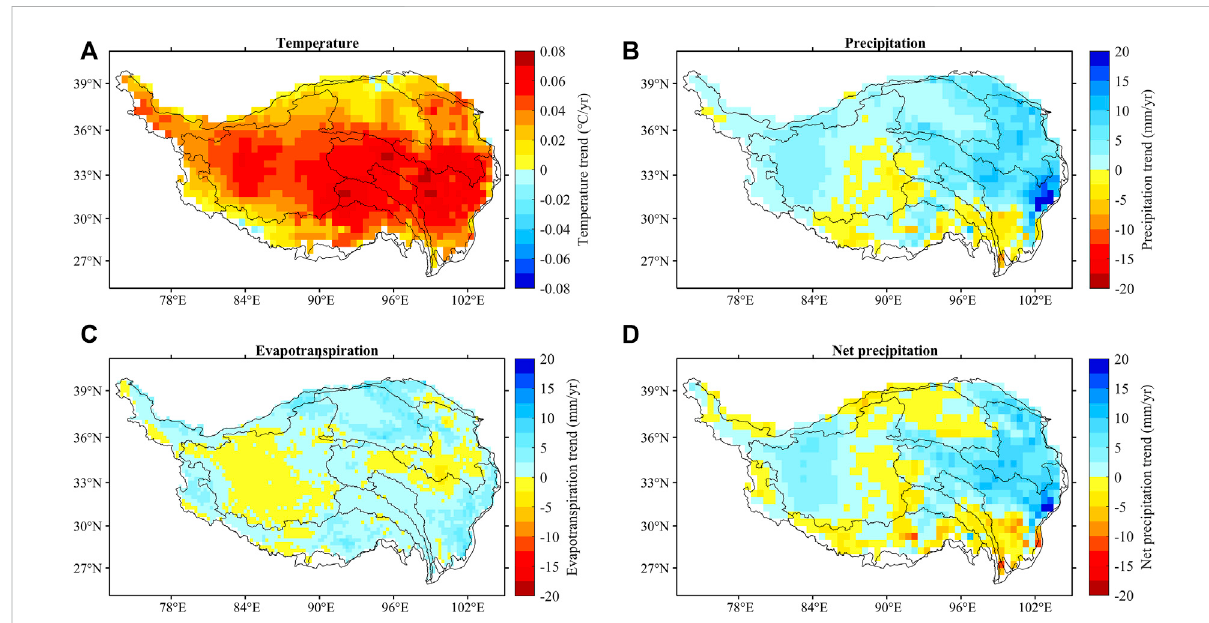
FIGURE 7 The spatial changes of temperature (A) , precipitation (B) , actual evapotranspiration (C) , and net precipitation (D) across the Tibetan Plateau during 2000 – 2019.